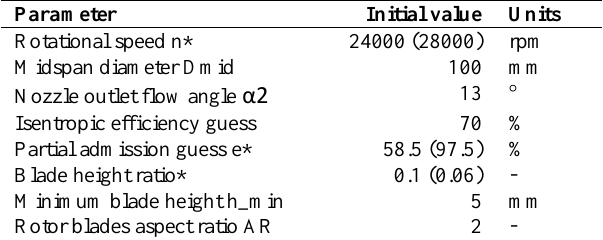
Table 2. Chosen input parameters and guesses; parameters